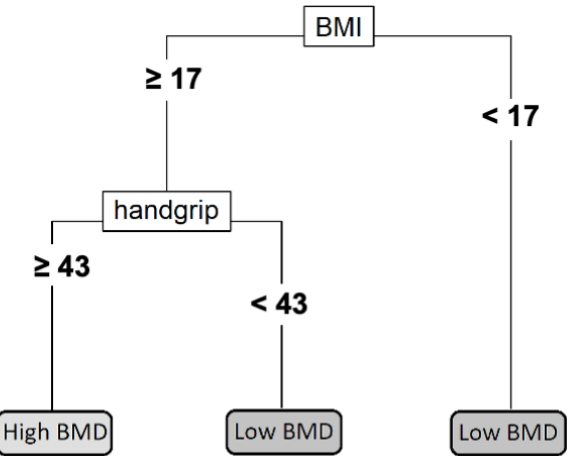
Figure 3. Individual decision tree. The handgrip strength is measured in kg by adding the results from both arms. The BMI is measured in kg/m 2 . Abbreviations: BMI: body mass index; BMD: bone mineral density.